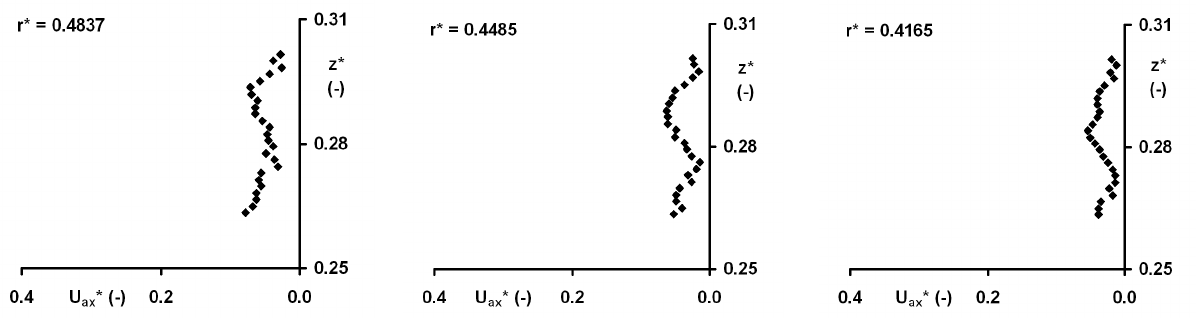
Fig. 7. Dimensionless axial mean velocity profiles )/( NDU